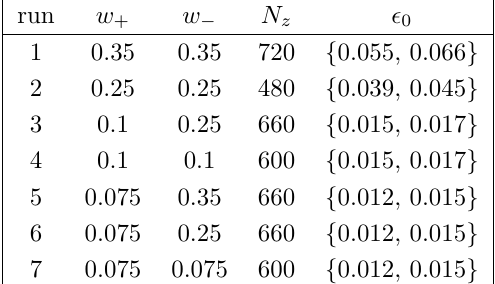
Table 2 . Physical and computational parameters of speci(cid:12)c computed collisions. Shown are the incoming shock widths w (cid:6) , number of longitudinal grid points N z , and background energy densities (cid:15) . Shock widths w (cid:6) are measured in units of (cid:22) (cid:0) 1 . The background energy density (cid:15) 0 the peak energy density of the narrower shock, or (cid:22) 3 w (cid:0) 1 values of (cid:15) were used to extrapolate to vanishing background energy density. 0